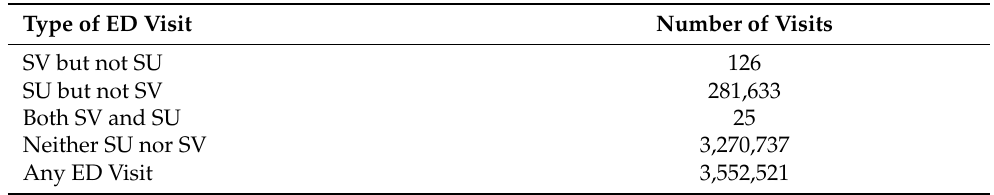
Table 3. ED Visits Involving Sexual Violence and/or Substance Use: HCUP Emergency Department Visit Database for Hawaii, 2005–2014.